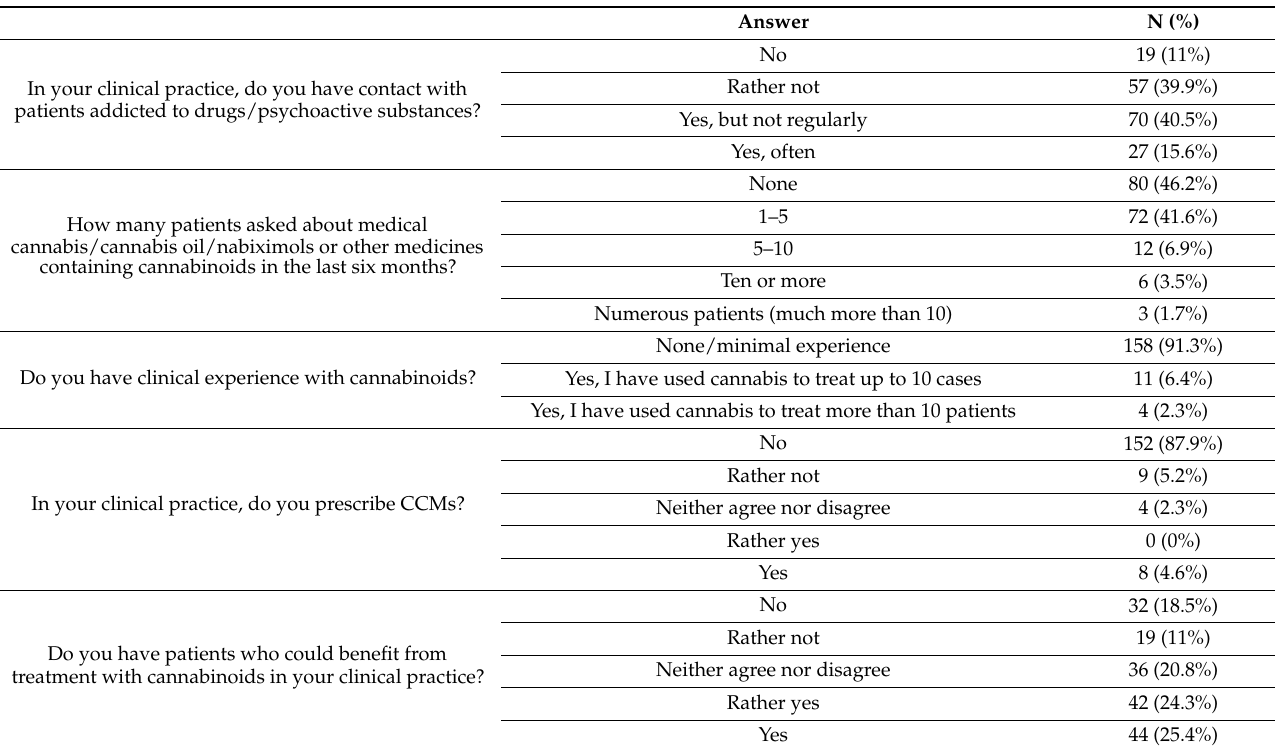
Table 2. Clinical aspects of medical cannabis and